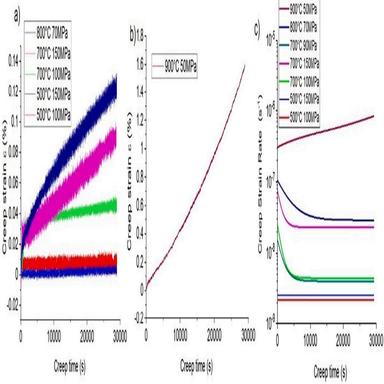
Curves of creep strain ε vs. time of the pseudo-creep tests for (a) temperatures between 500C and 800C and (b) for 900C 50 MPa, and (c) the evolution of creep strain rate ε ˙ under different experimental conditions.